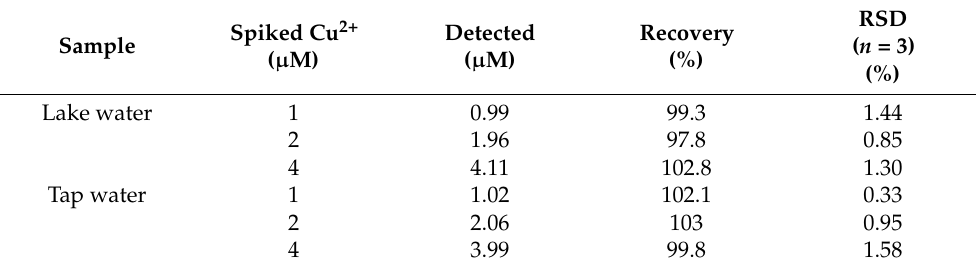
Table 3. Determination of Cu 2+ in lake water and tap water. ( n is the number of repeated experiments, 95% confidence level, RSD = recovery standard deviation).